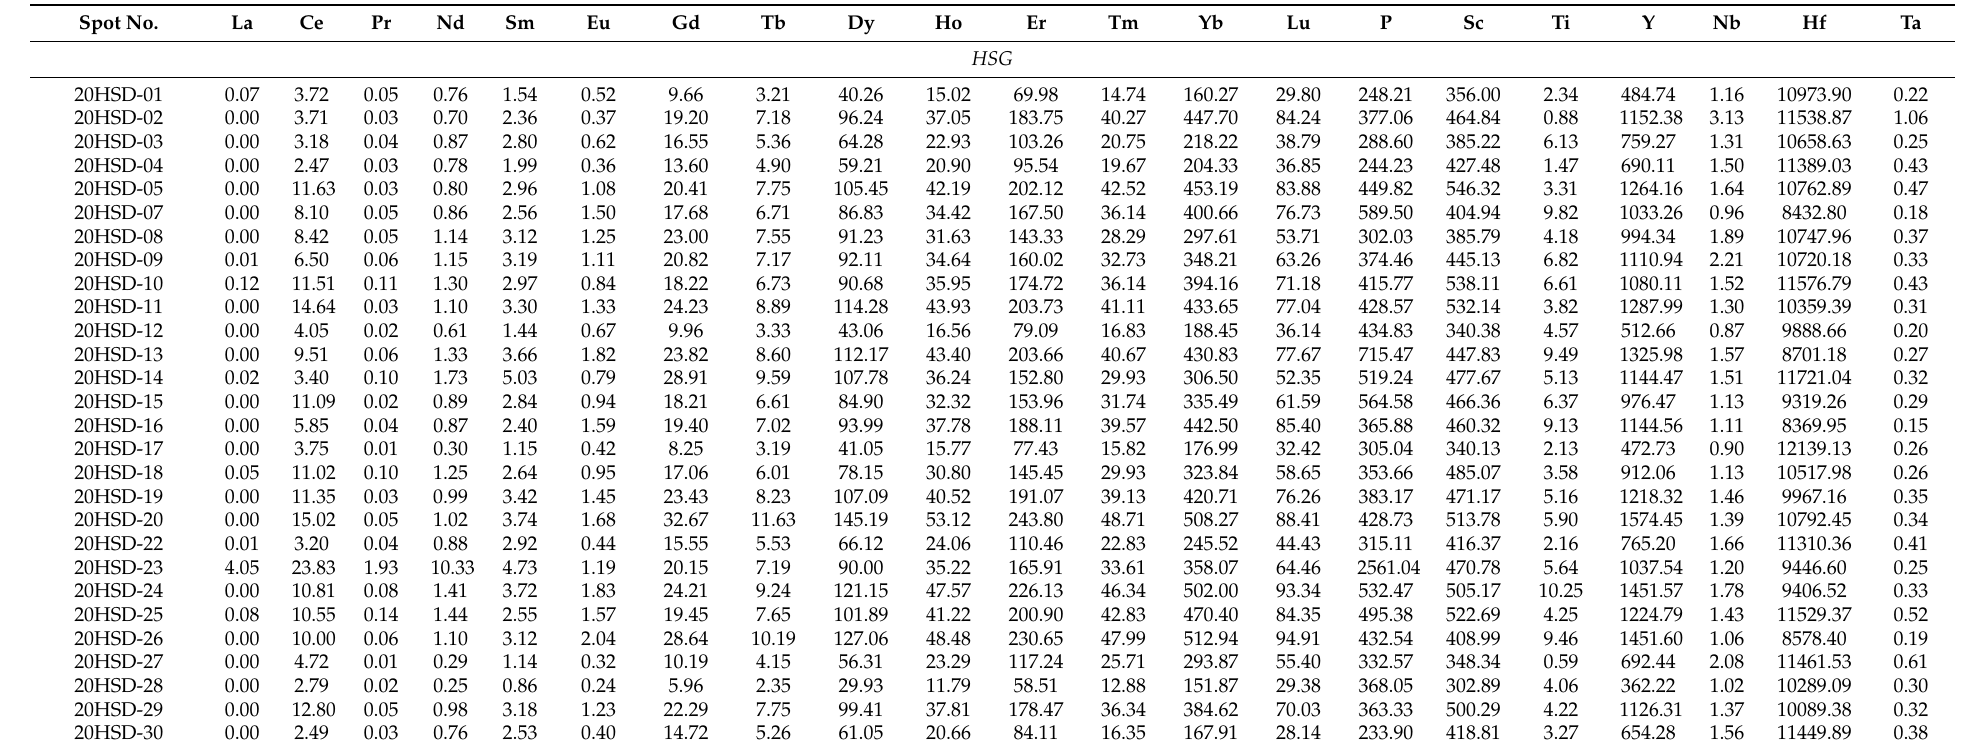
Table 3. Trace element compositions (10 − 6 ) of zircon grains from the HSG and HDG of the KDSZ. Spot